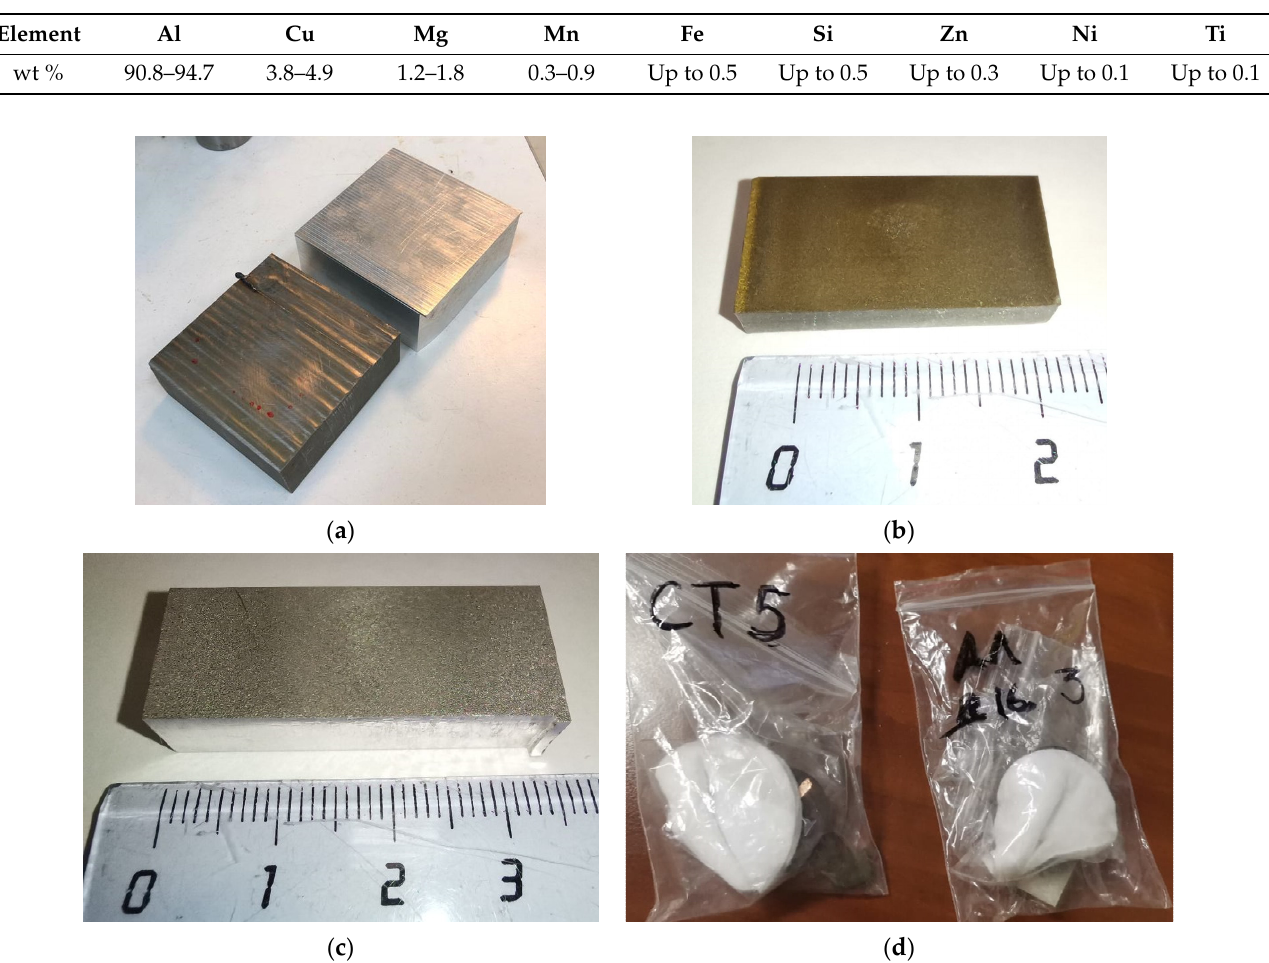
Figure 3. Specimens: ( a ) before machining; ( b ) X10CrNiTi18-10 (12kH18N10T) steel specimen for surface characterization; ( c ) 2024 (D16) duralumin specimen for surface characterization; ( d ) specimens for controlling the specific electrical resistance ρ and photoelectron spectroscopy.